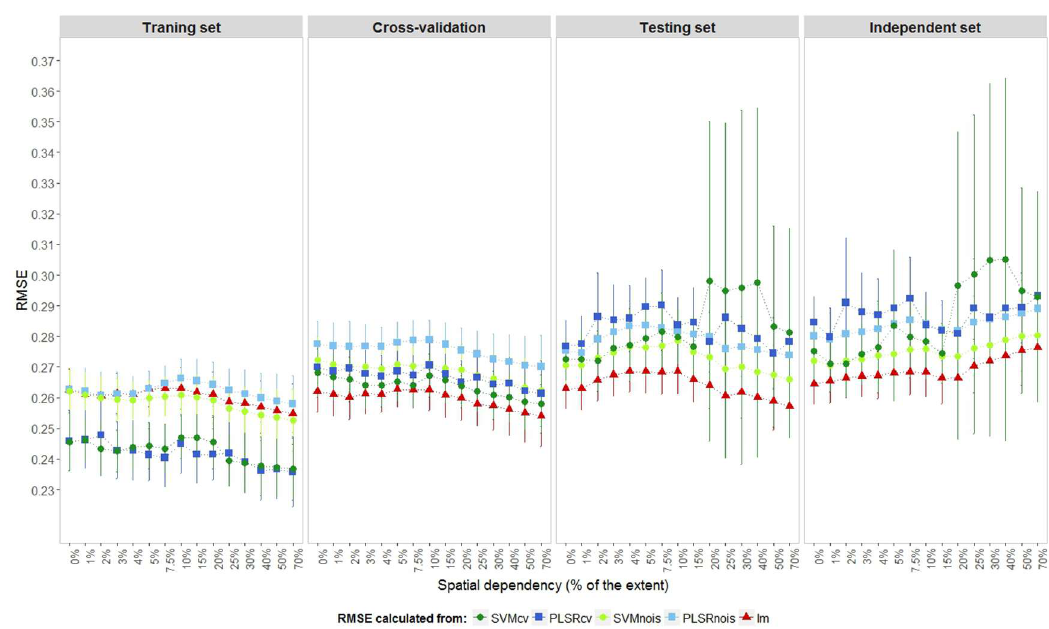
Figure 4. Mean and confidence intervals for prediction error, Root Mean Squared Error (RMSE), by level of spatial dependency estimated from the training set (RMSEtr), cross-validation subsets (RMSEcv), testing sets based on a different sample subset from the same landscape (RMSEtest), and independent testing sets (RMSEind). The different shapes represent different models: squares for PLSR, circles for SVM and triangles for the linear regression model (lm). The darker shades represent the models tuned via traditional cross-validation (PLSRcv and SVMcv), the lighter shades those tuned via the NOIS method (PLSR_NOIS and SVM_NOIS).